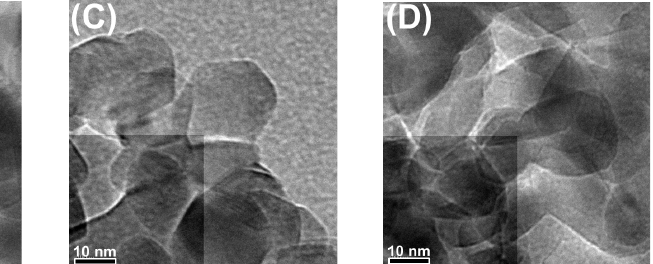
Figure 2. TEMs of MnO ( A ) P-25; ( B ) Γ = 0.16; ( C ) Γ = 0.76; ( D ) Γ =